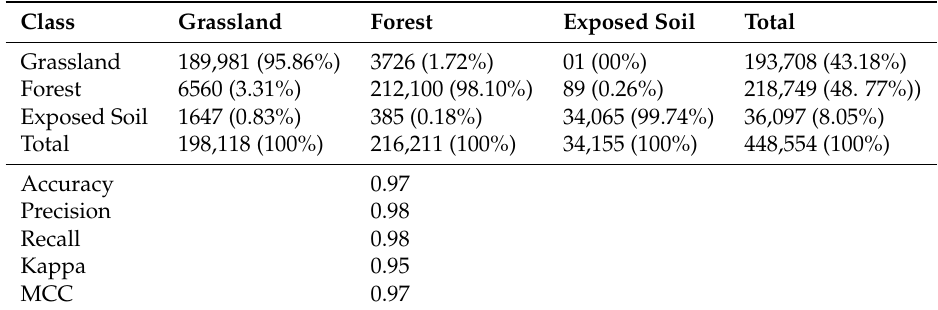
Table 10. Predicted image classification confusion matrix and evaluation measures. The percentage values are related to the number of classified pixels in the